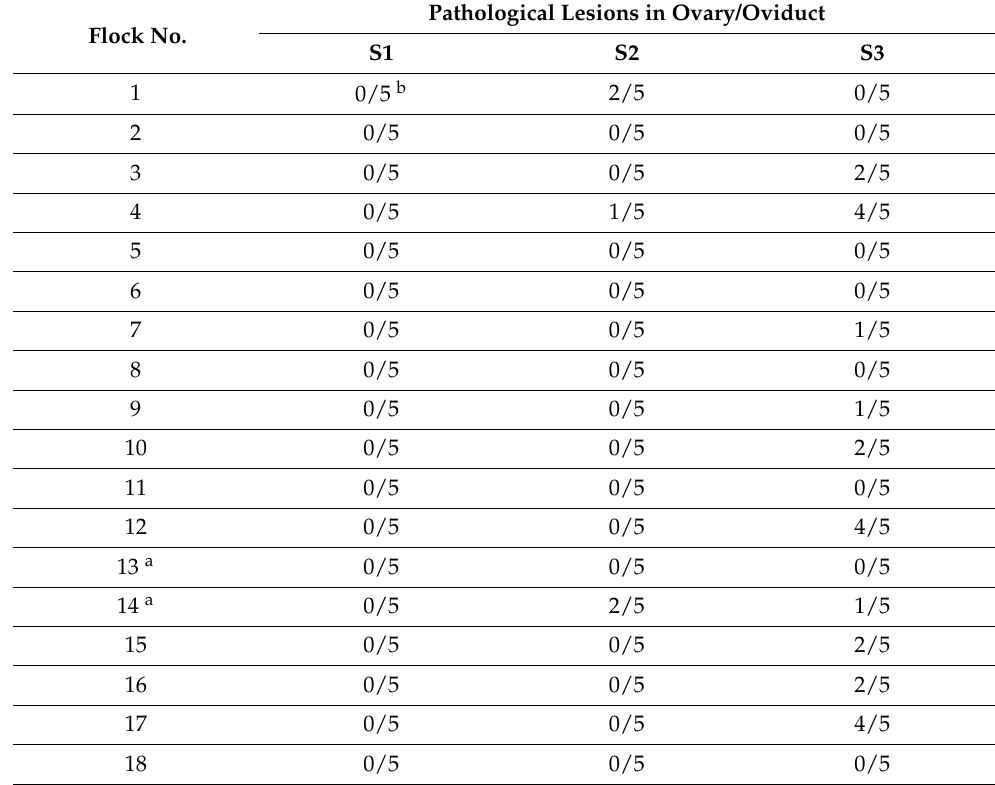
Table 1. Occurrence of pathological lesions in ovary/oviduct. Flock